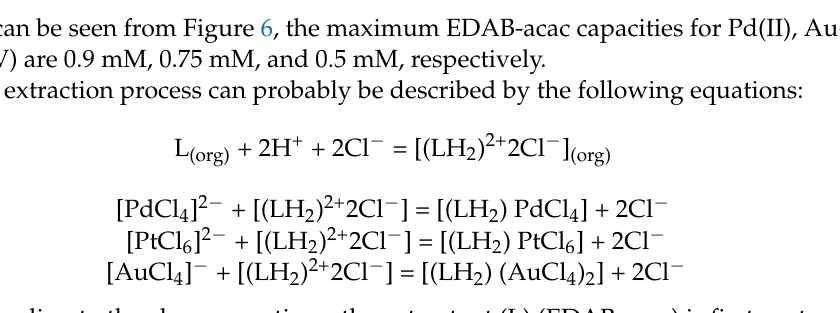
Figure 6. Extraction isotherms of Pd(II), Au(III), and Pt(IV) ions with EDAB-acac in methylene chloride. Initial concentration of each metal ions in the range of 0.5 and 5 mM.